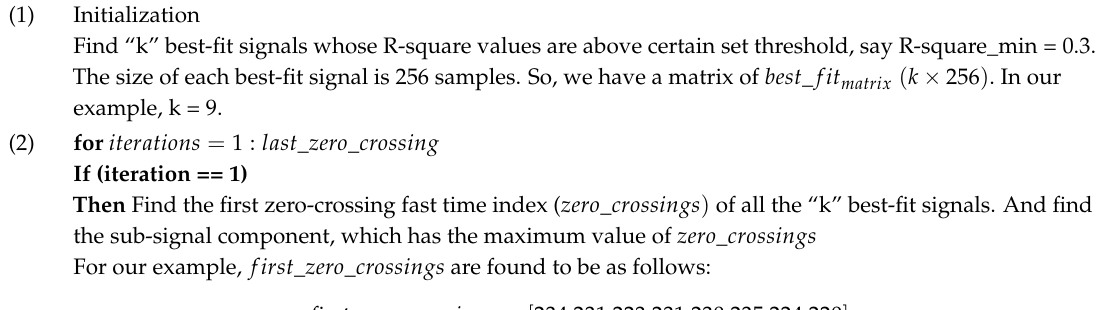
Algorithm 3: Step by step construction of the vital signal from the best fit signals (1)